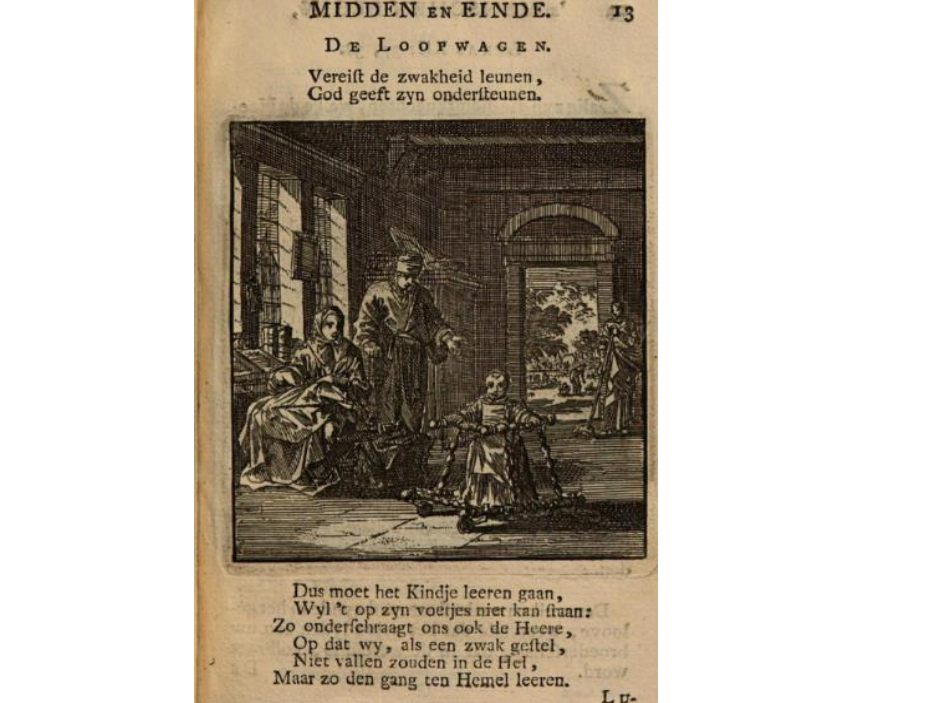
Figure 2. Jan Luyken, “De Loopfwagen,” Des Menschen, Begin, Midden en Einde , 1712.